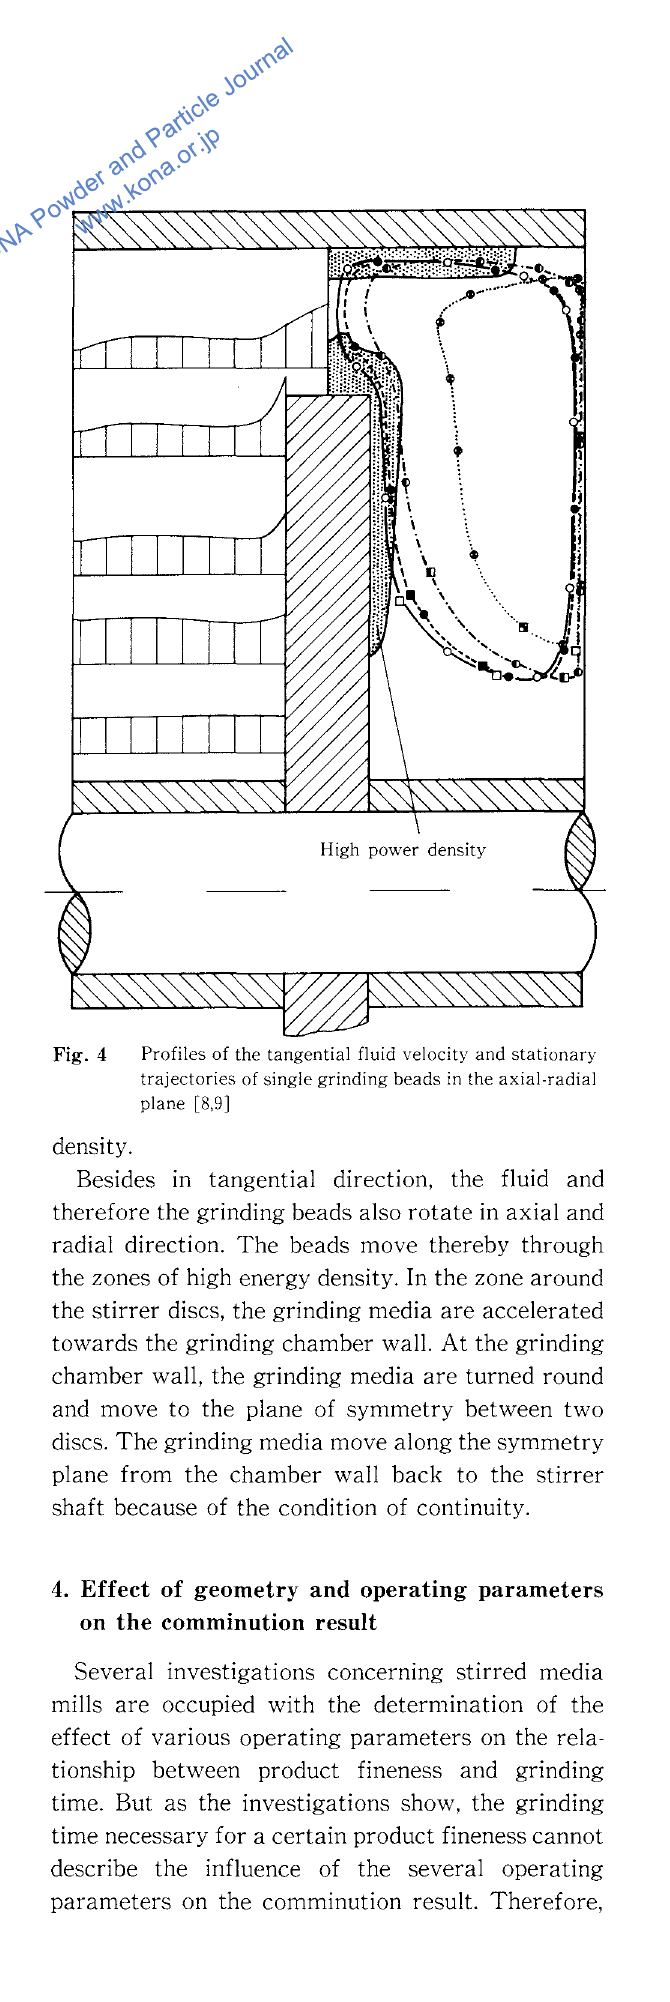
Relationship between product fineness (integral mean size xu) and specific energy for the comminution of